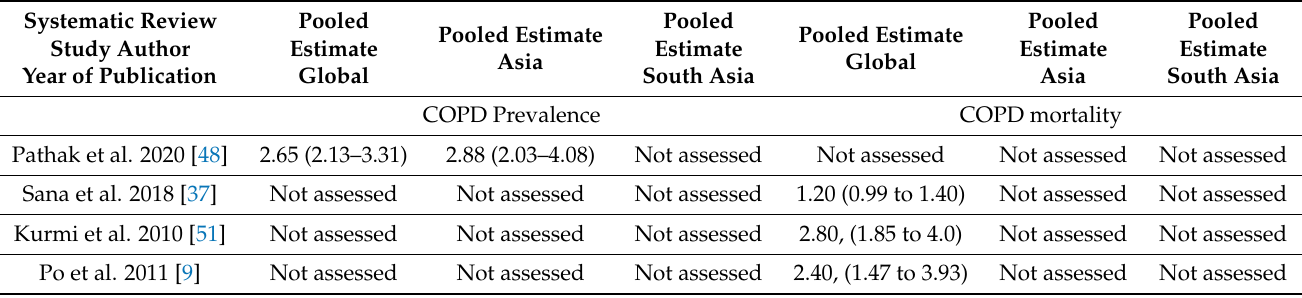
Table 5. Pooled Estimates of Systematic Reviews showing COPD Prevalence and Mortality in the past two